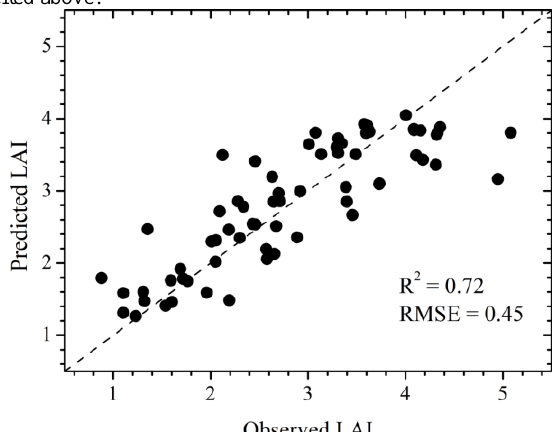
Figure 3. The comparison between the observed LAI values from LAINet and the predicted LAI values from GPR. The dashed line represents the 1:1